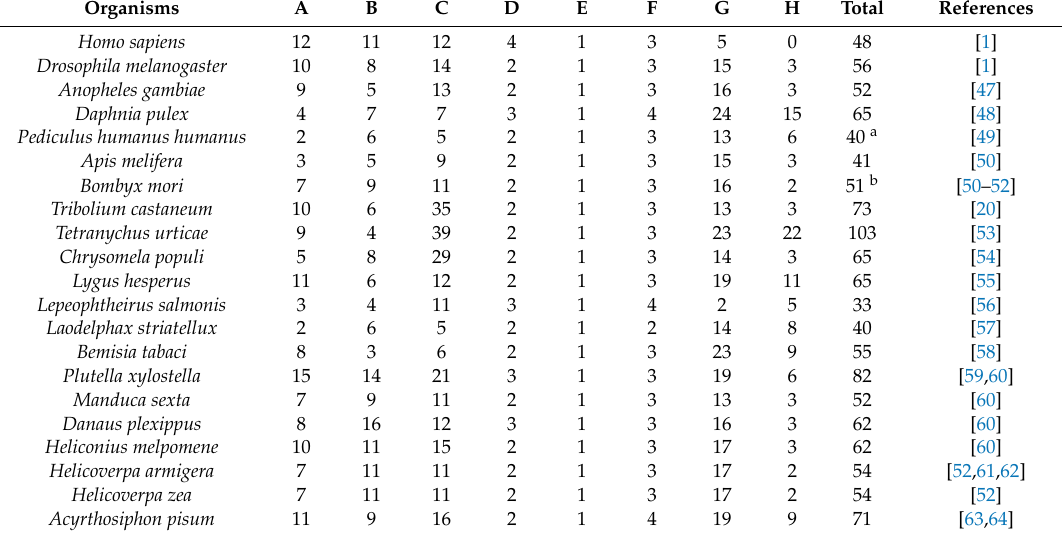
Table 1. Distribution of genes among ABC transporter subfamilies for di ff erent arthropods and Homo sapiens